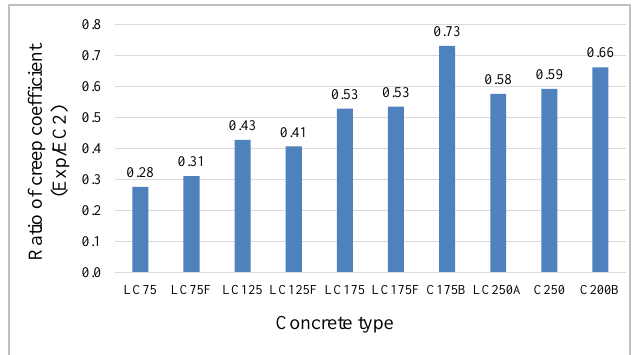
Figure 8. Ratio between creep coefficients Exp/EC2.